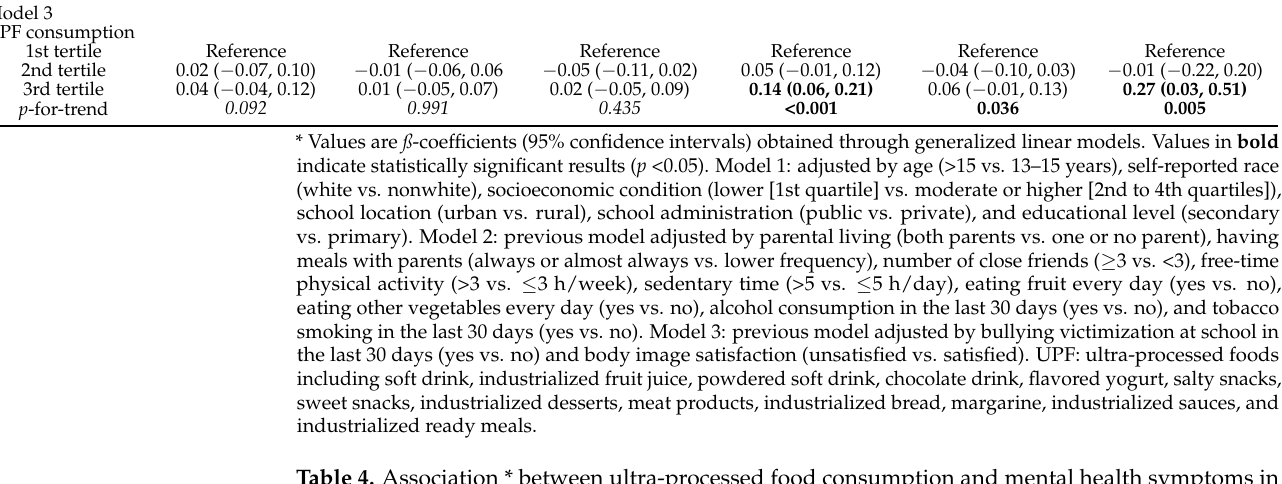
Table 4. Association * between ultra-processed food consumption and mental health symptoms in adolescent student girls aged 13–17 years, Brazil, 2019. Frequency of Mental Health Symptoms (Ranging from 1-Never to 5-Always) Models Feeling Irritable, Nervous, or